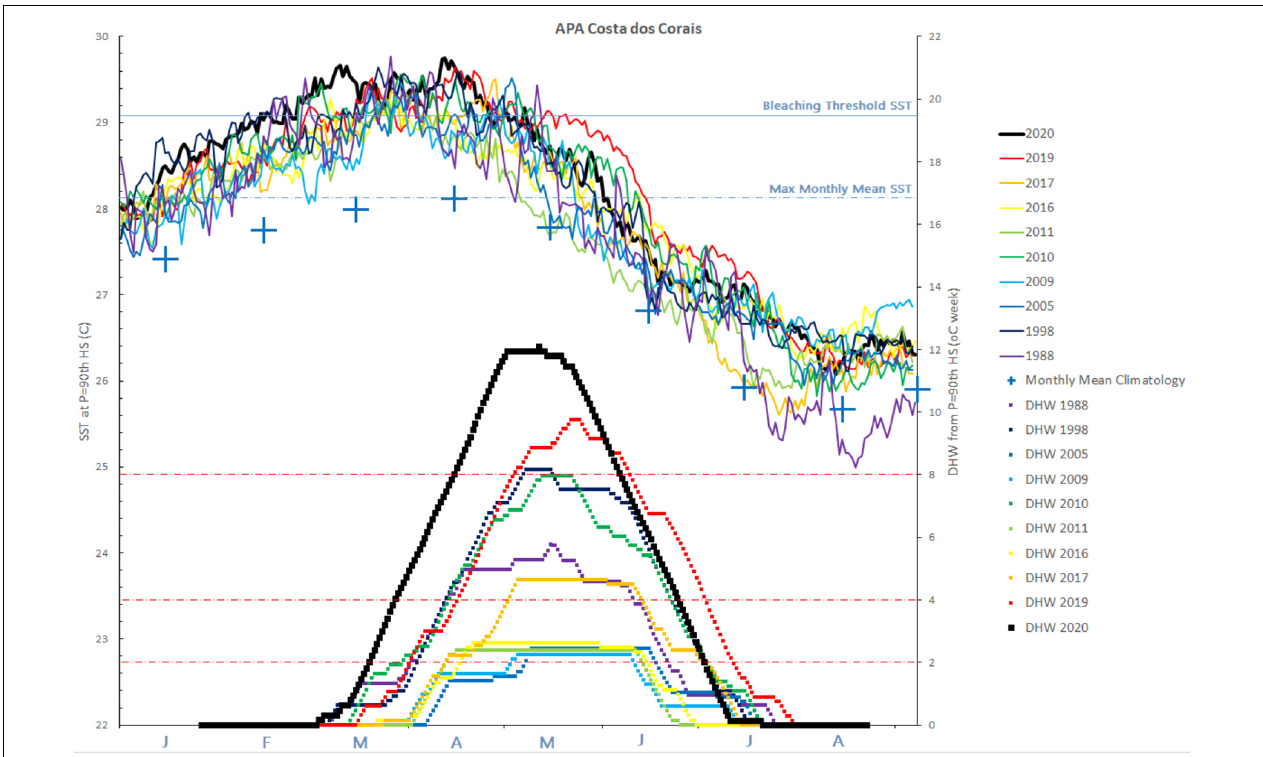
FIGURE 3 | Sea surface temperature (SST) and degree heating week (DHW) series for the ten largest anomalies since 1985, when records became available for the Costa dos Corais Regional Virtual Station (CCRVS). Black line highlights the 2020 thermal stress event.